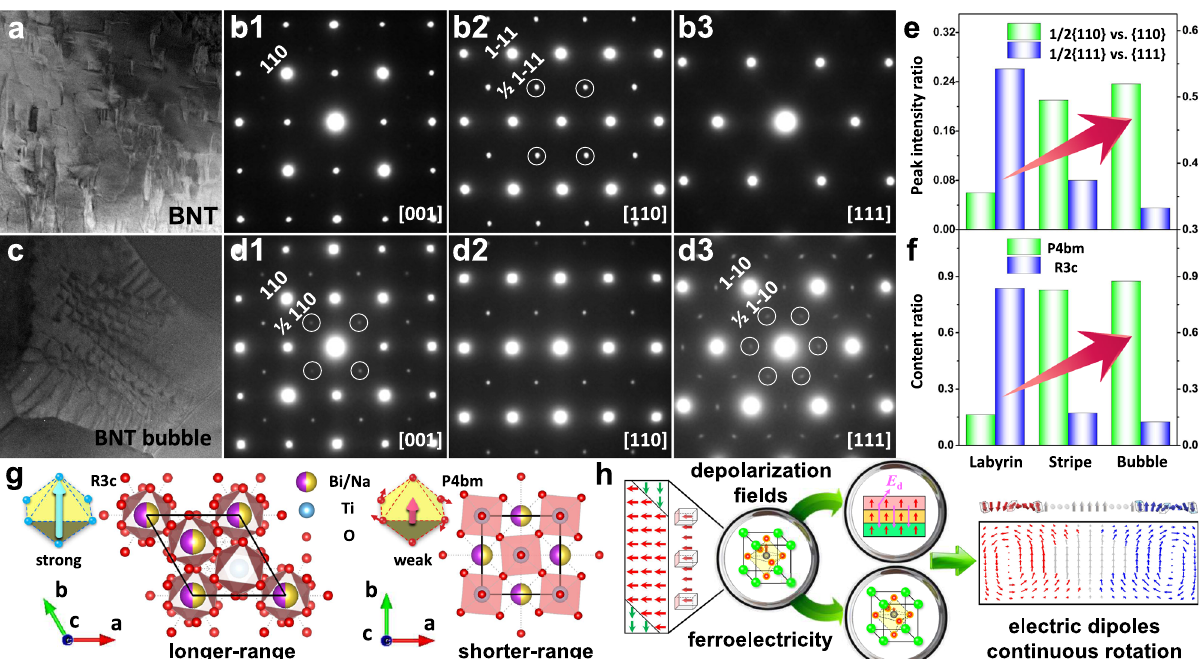
Fig. 3 Structural essence accompanied with the evolutionary domains. TEM bright- fi eld images of the representative a BNT-labyrinthine and c BNT- bubble samples. b1 − b3 , d1 − d3 Electron diffraction patterns of BNT-labyrinthine and BNT-bubble samples, respectively, along [001] pc , [110] pc , and [111] pc zone axes. e Peak intensity ratios of {110} vs. ½{110} and ½{111} vs. {111}re fl ections. f Relative ratios of P4bm and R3c content for BNT-labyrinthine, BNT- stripe, and BNT-bubble samples. g Structural models of R ( R3c) and T ( P4bm ) phases viewed along c axis. h Driving forces utilized to achieve bubble domains in bulk ferroelectrics, and the expected continuous rotation of electrical dipoles in